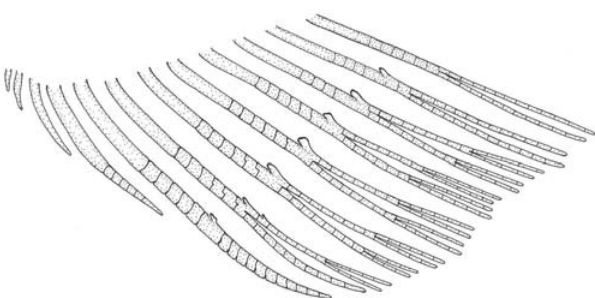
Fig. 33. Mimagoniates inequalis , adult male, MCP 9892, 37.0 mm SL; anterior 12 anal-fin rays, lateral view, left side. First branched ray bears two hooks.